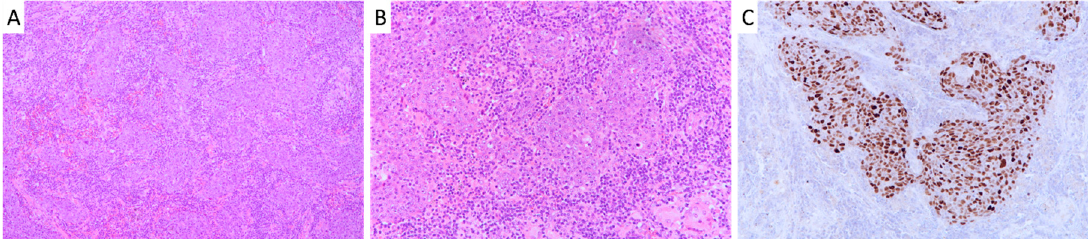
Figure 1. Histology of pulmonary lymphoepithelioma-like carcinoma. ( A ) and ( B ) Hematoxylin and eosin staining of pulmonary LELC showing large tumor cells intermixed with extensive lymphocytes. (Original magnification ×100 in A; ×200 in B). ( C ) Presence of Epstein–Barr virus in pulmonary LELC shown by in situ hybridization of Epstein–Barr virus-encoded small RNAs (Original magnification ×200). LELC, lymphoepithelioma-like carcinoma.